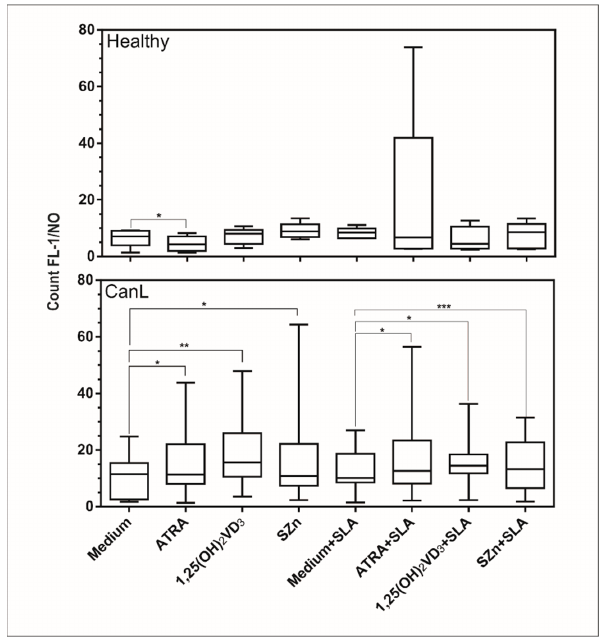
Figure 2. NO production by spleen leukocytes of dogs with CanL and healthy dogs supplemented with nutrients. Spleen leukocytes from CanL ( n = 15) and healthy dogs ( n = 5) were cultured in the medium alone or with the addition of ATRA, 1,25(OH) 2 VD 3 and SZn, with and without SLA. NO production in the cell culture was determined by flow cytometry after 20 h. Bars represent the median and IQR with minimum and maximum error bars. Asterisks indicate a significant difference for the comparisons within the treatment (Wilcoxon test, * p < 0.05, ** p < 0.01, and *** p < 0.001).